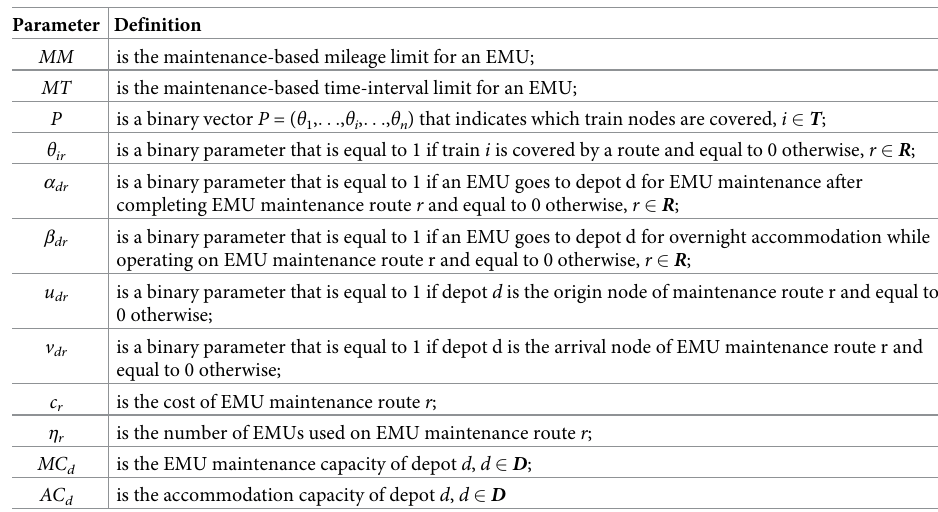
Table 2. Parameter symbol